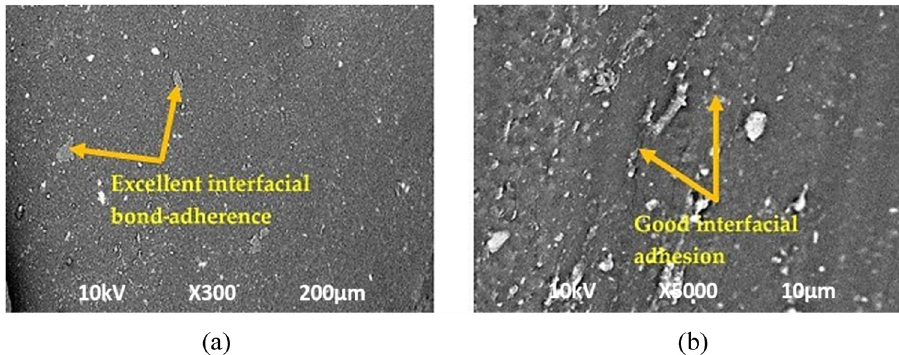
Figure 49: Micrographs of neat recycled EVA polymer without leather fi bers at a magni fi cation of: ( a ) 300 × and ( b ) 5,000 × .